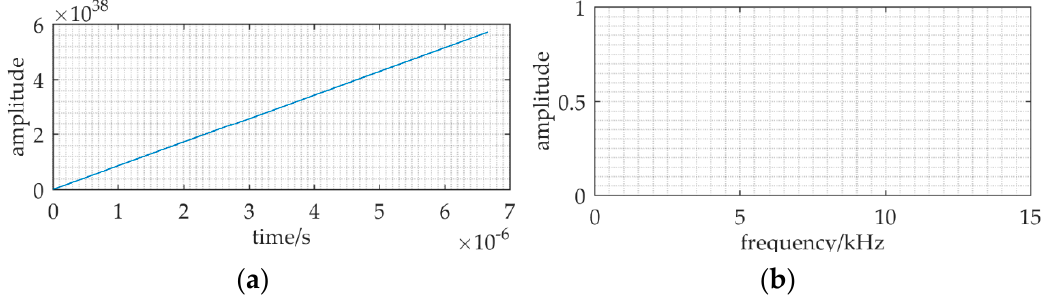
Figure 11. The result of RFSR applied to the ULB signal detection when the sampling frequency is f s = 150 kHz, and the sampling data length is N = 1500. The re-scaling ratio of RFSR is R = 3.75 × 10 6 . In addition, the other relative parameters: A = 0.15, f = 37.5 kHz, a = 1, b = 0.344, D = 0.9. ( a , b ) are the waveform and frequency spectrum of the output.